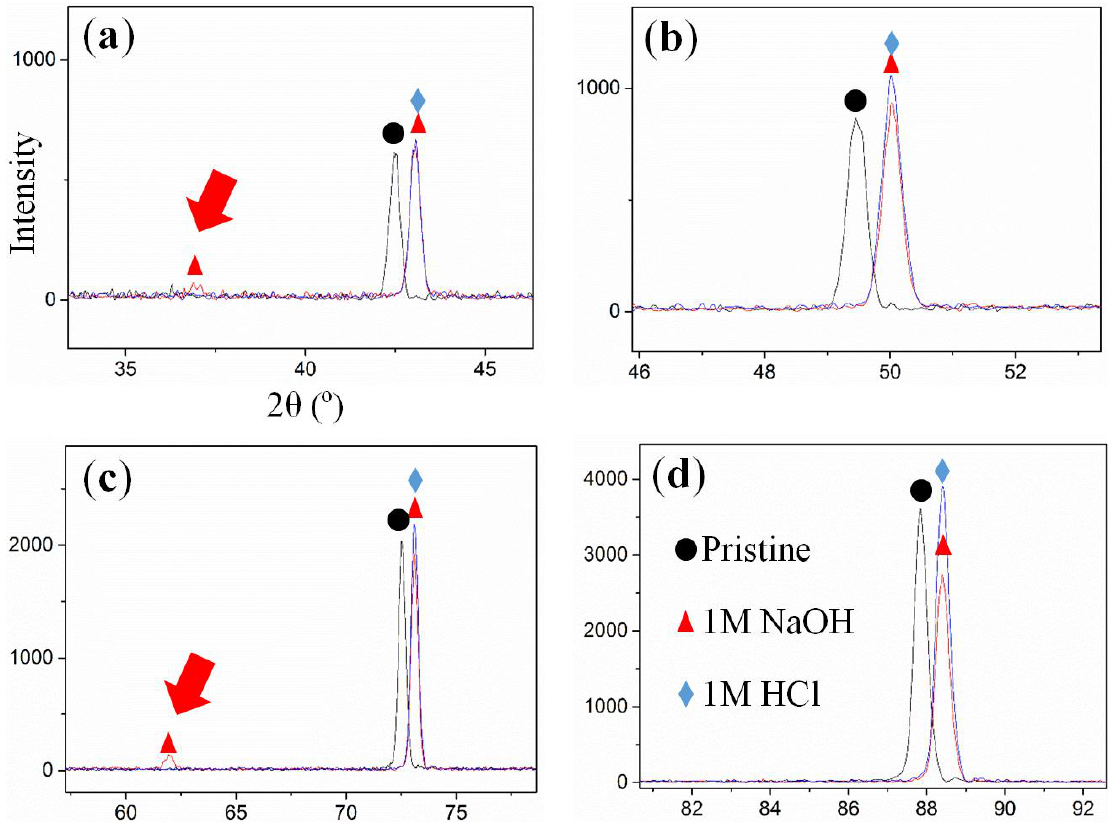
Figure 6. X-ray diffraction (XRD) patterns of de-alloyed CuZn 30 foil de-alloyed with 1 M NaOH and 1 M HCl: ( a ) 2θ = 35°–45°; ( b ) 2θ = 46°–53°; ( c ) 2θ = 62°–77°;